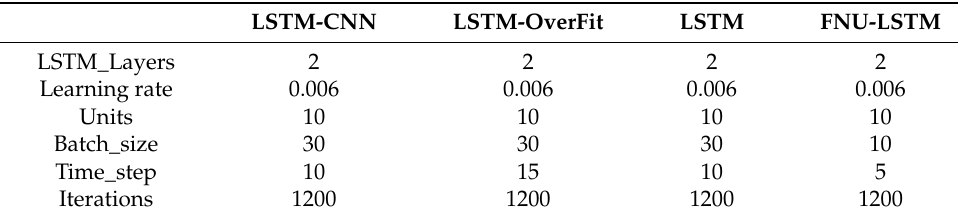
Table 8. The training hyperparameters of models.